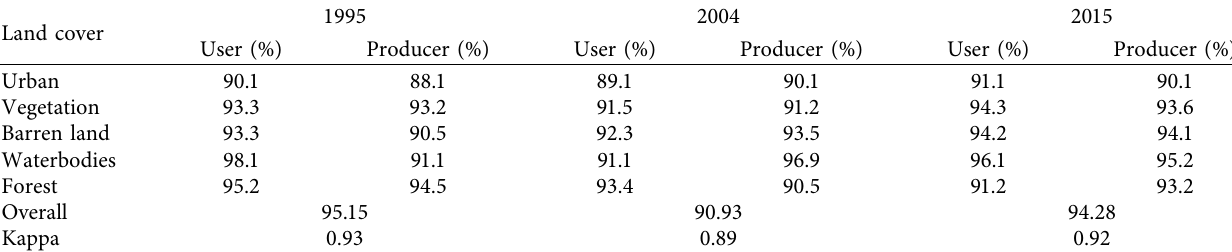
Table 2: Accuracy of multitemporal LULC classifications